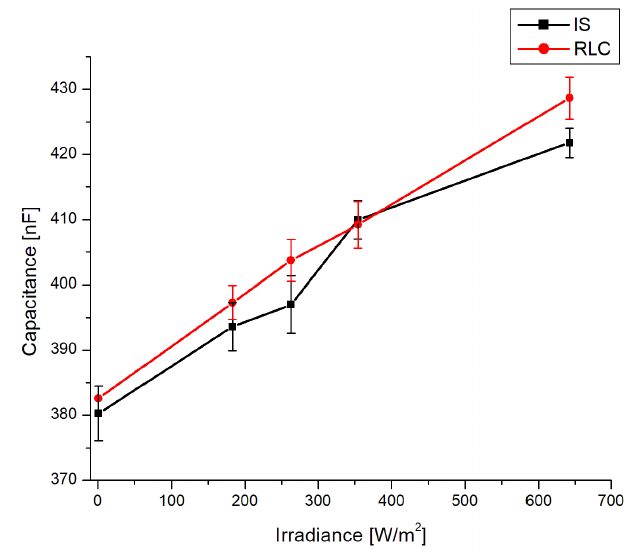
Figure 8. SC capacitance obtained through IS and RLC methods.